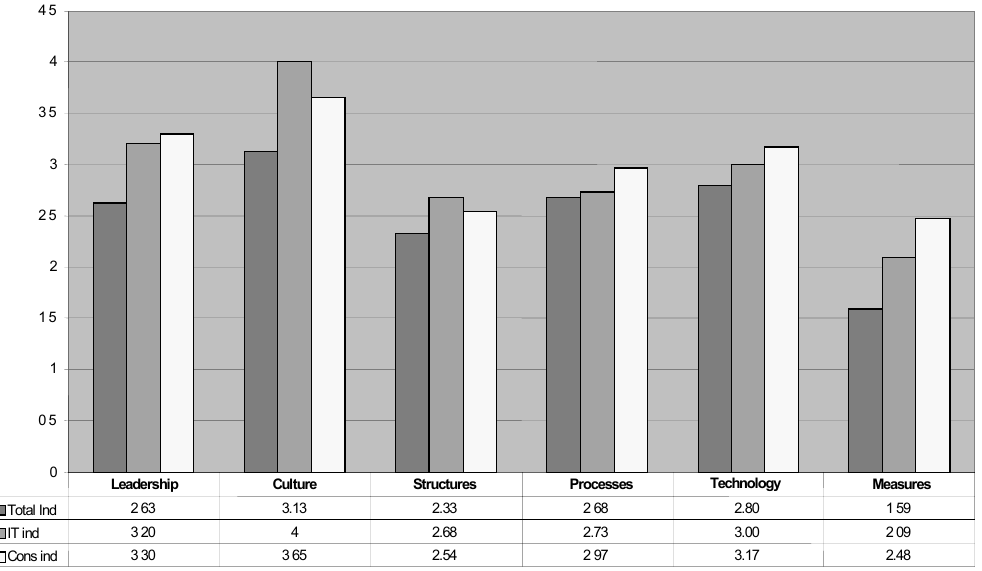
Figure 3 - Comparison of KM practices for 3 industry categories on the 6 main